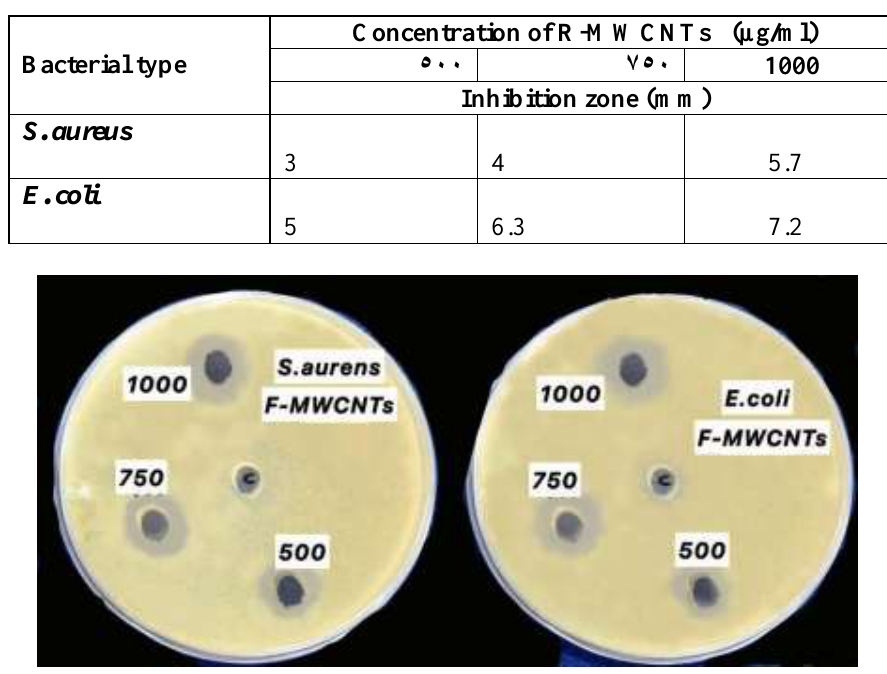
Table 1: Inhibition Zone diameter (IZ) with different concentrations of antibacterial R-MWCNTs against S . aureus and E . coli and b) the table of (IZ) against S . aureus and E . coli .